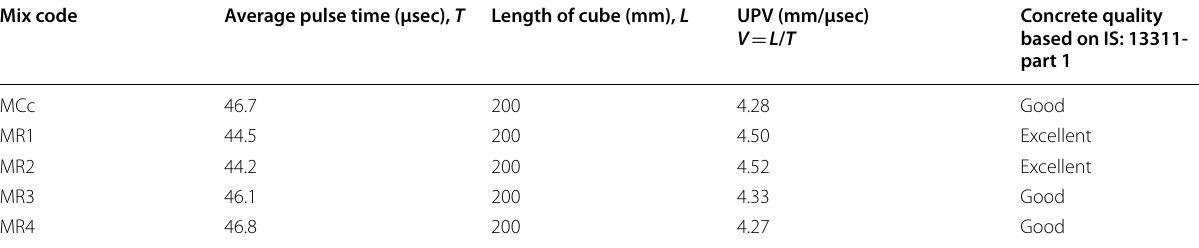
Table 8 Average UPV test result for cylinder sample Mix